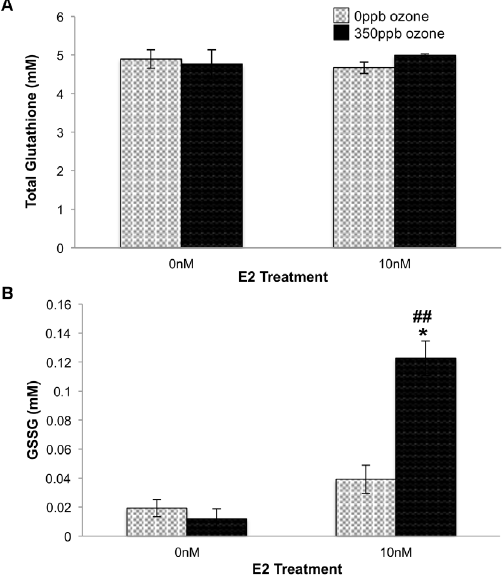
Figure 5. Effect of E2 and O 3 on total glutathione (A) and GSSG (B) 24 hr after gas exposure. 10 4 L2 cells/well were treated with E2 and 350 ppb O 3 as indicated. After 24 hr recovery time total glutathione (F=0.3699, df=3,11, p=0.7770) and GSSG (F=33.0667, df=3,11, p , 0.0001) levels were determined. Values represent the mean of 3 replicates, 6 S.E.M. ** p # 0.01 relative to the same E2 treatment. ## p # 0.01 same O 3 exposure.